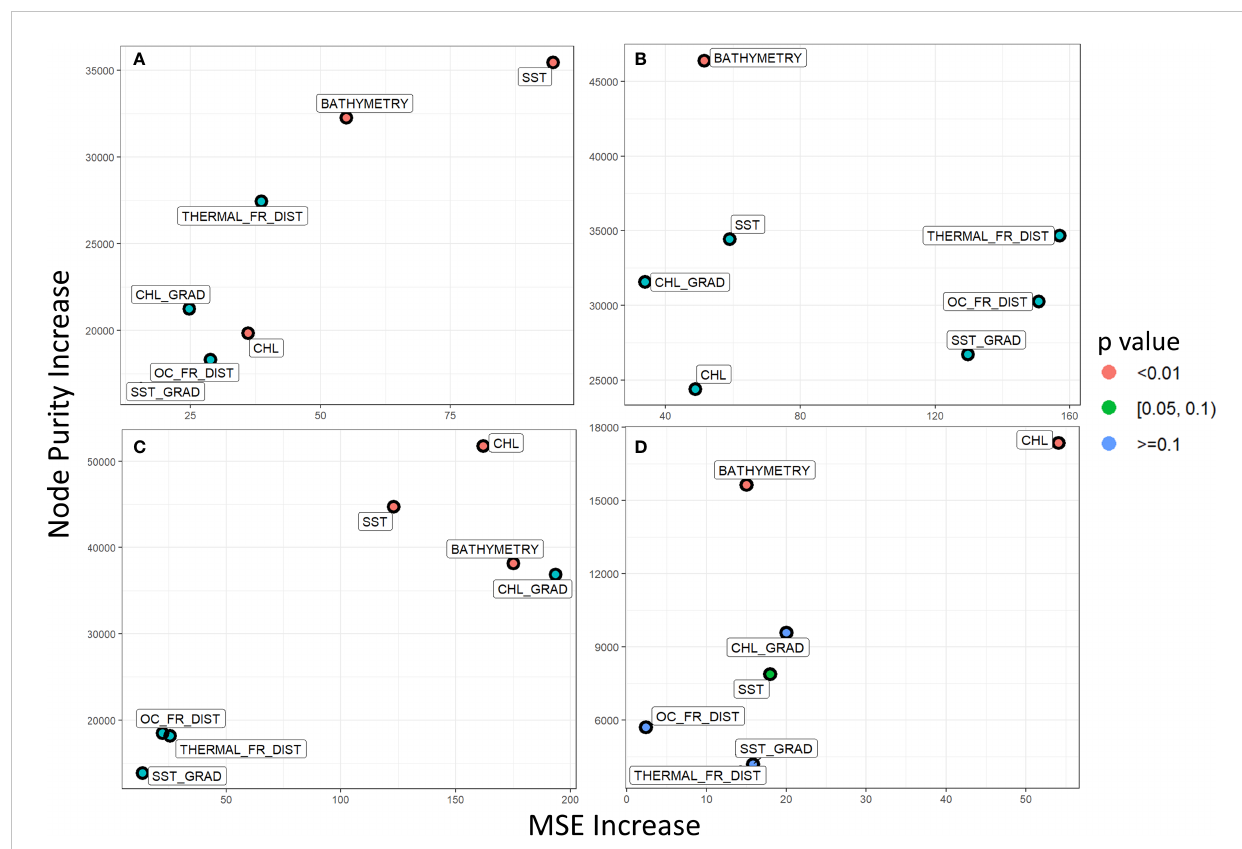
FIGURE 6 Multi-way variable importance plot for the Random Forest Regression Models for each species and each area. (A) Anchovy in TS, (B) Sardine in TS, (C) Anchovy in GT and (D) Sardine in GT. The p-value refers to the signi fi cance of each variable if it is used for splitting more often than would be the case if the selection was